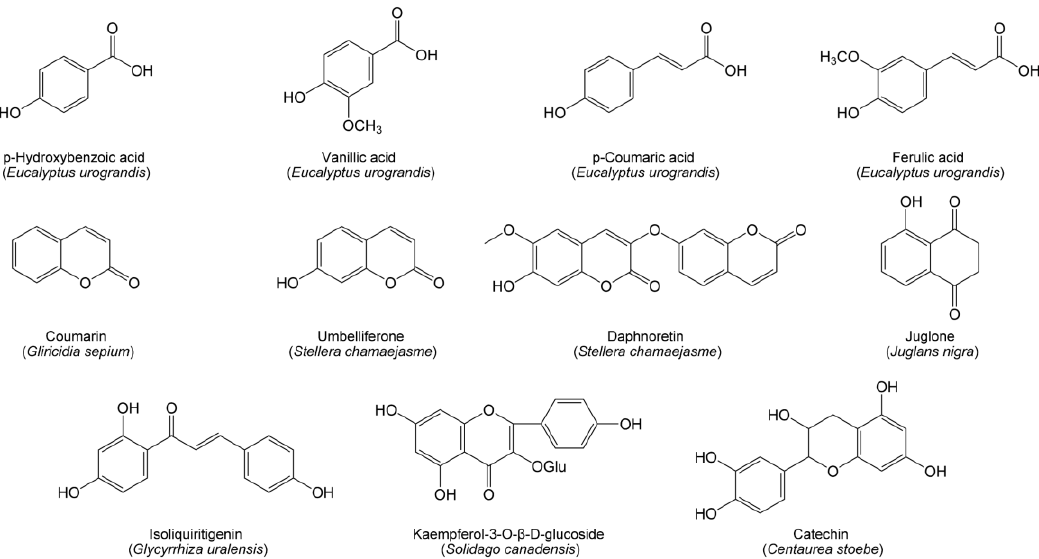
Figure 1. Phenolic allelochemicals from herbaceous and woody species in grasslands and forests.